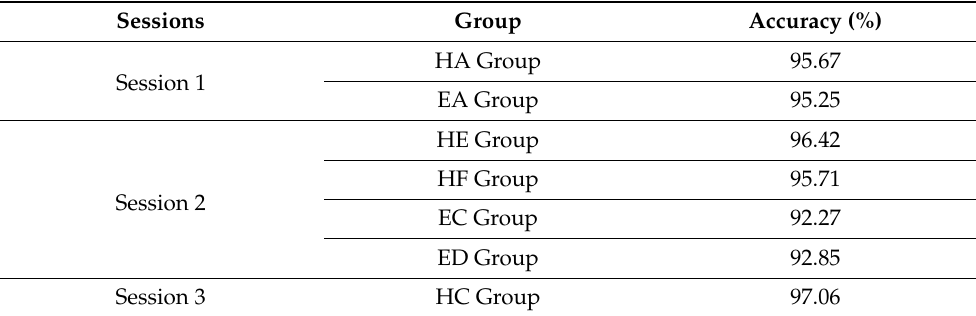
Table 10. The performance of the screening diagnostic tool using different environments. Sessions